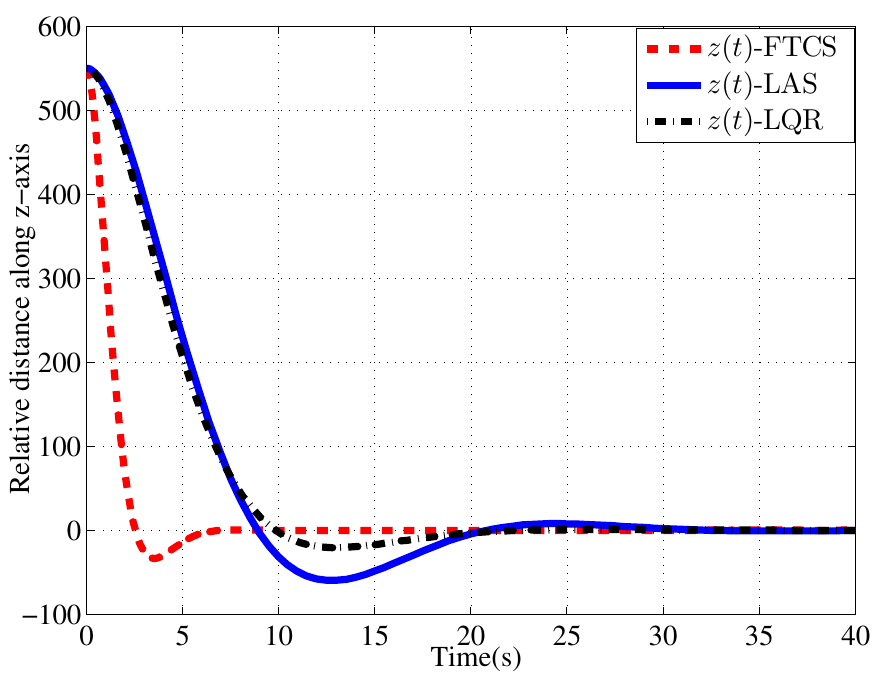
Figure 5. Relative position along z -axis under different control laws.